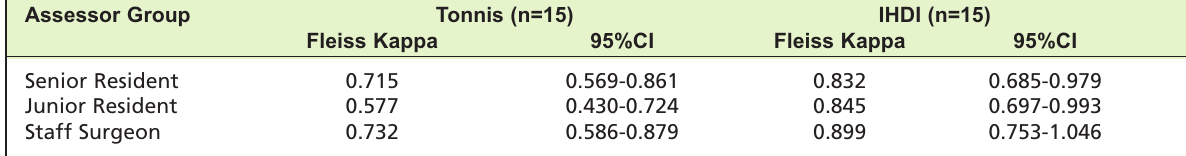
Interobserver reliability for Tonnis and IHDI classifications in all groups Table II: